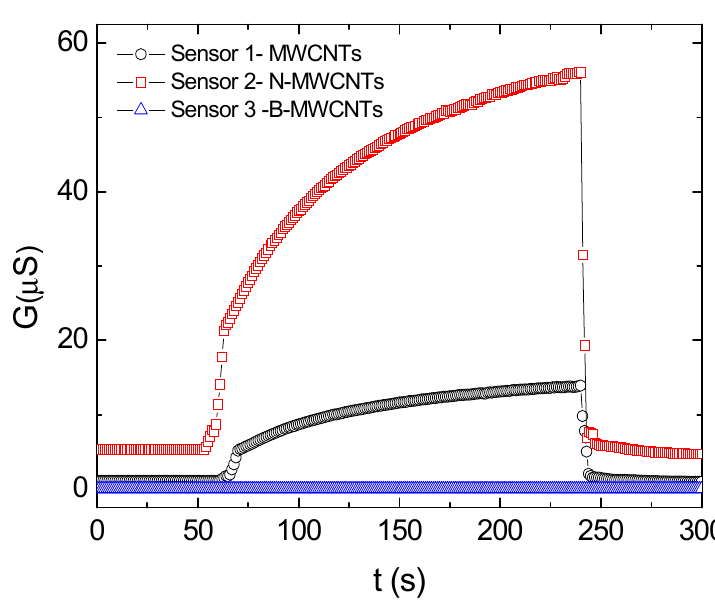
Figure 4. G(t) response of the composite-based chemical sensors. At t = 60 s, the sensor is exposed to the recipient environment containing the fruits. At t = 240 s, the sensor is exposed again to air.